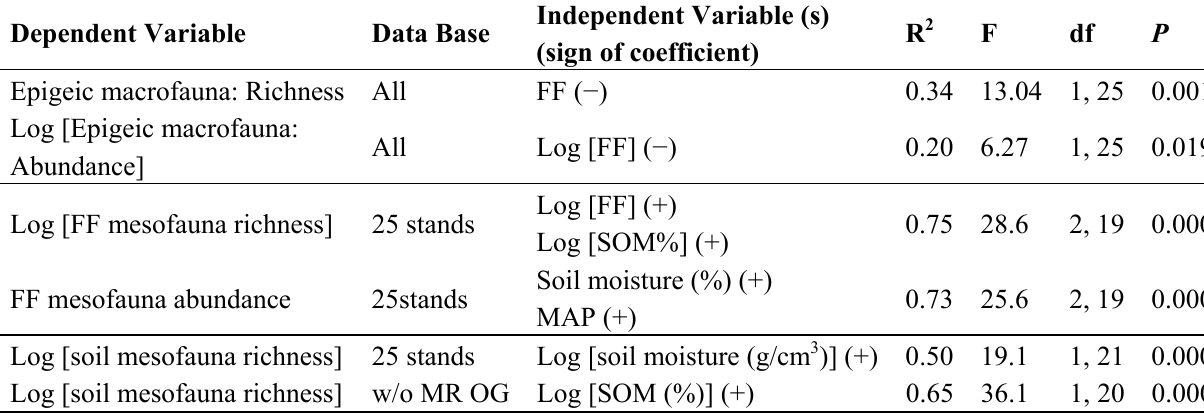
Table 4. Significant regression models for arthropods. FF = forest floor depth; MAP = mean annual precipitation; MROG = Marten Ridge old growth. Data for FF and soil mesofauna was collected on only 25